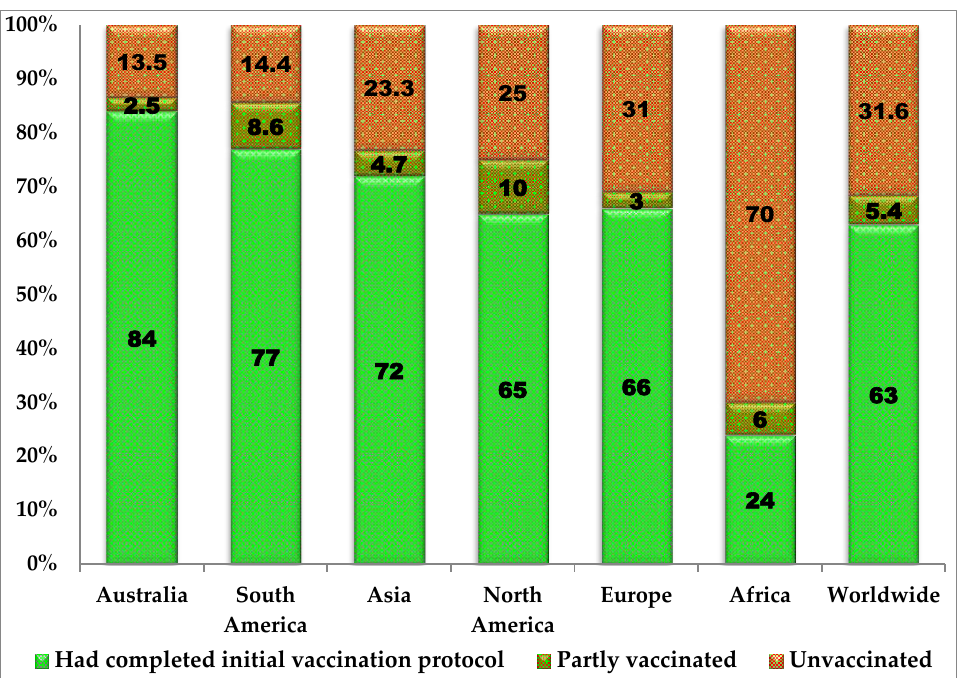
Figure 3. Global distribution of COVID-19 vaccination status in various continents as of 25 October 2022 (adapted from https://ourworldindata.org/coronavirus, accessed on 25 October 2022) [13]).